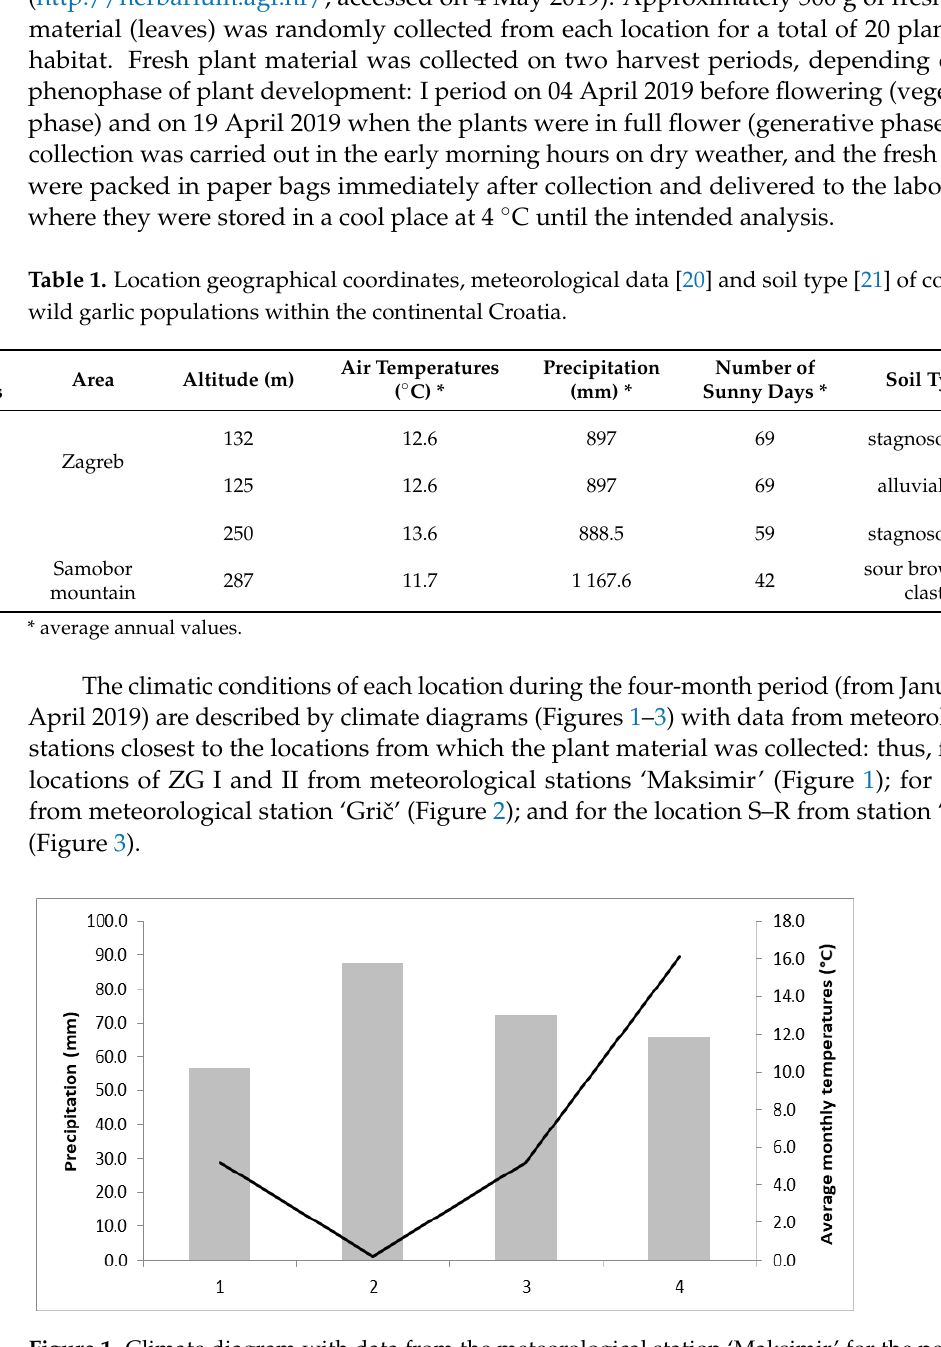
Figure 1. Climate diagram with data from the meteorological station ‘Maksimir’ for the period of January (1) to April (4) (Croatian Meteorological and Hydrological Service, 2019). Columns represent precipitation (mm), while line the average monthly temperatures ( ◦